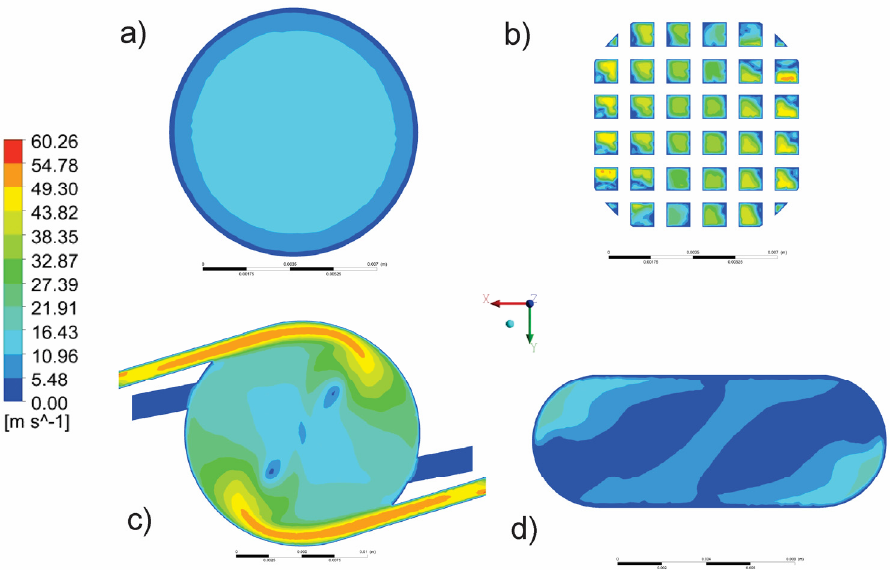
Figure 6. Fluid velocity magnitude in characteristic cross-sections: ( a ) outlet, ( b ) grid zone, ( c ) central chamber, and ( d ) capsule chamber.